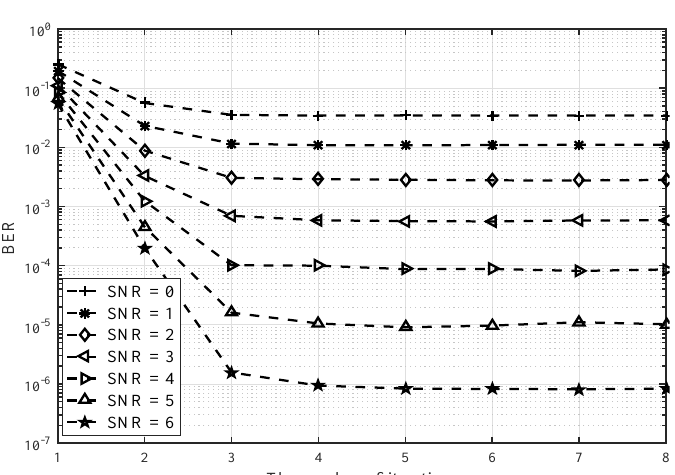
Figure 5. BER of the improved Kaczmarz algorithm with different number of iterations and SNR (128 × 16).